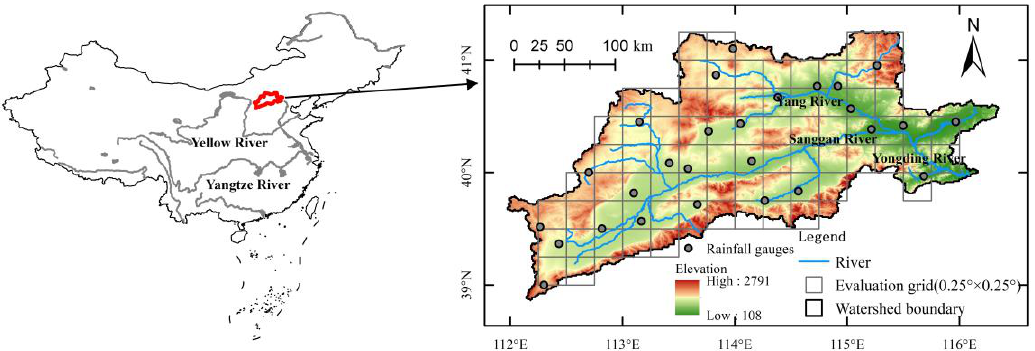
Figure 1. Geographical location of the study area.